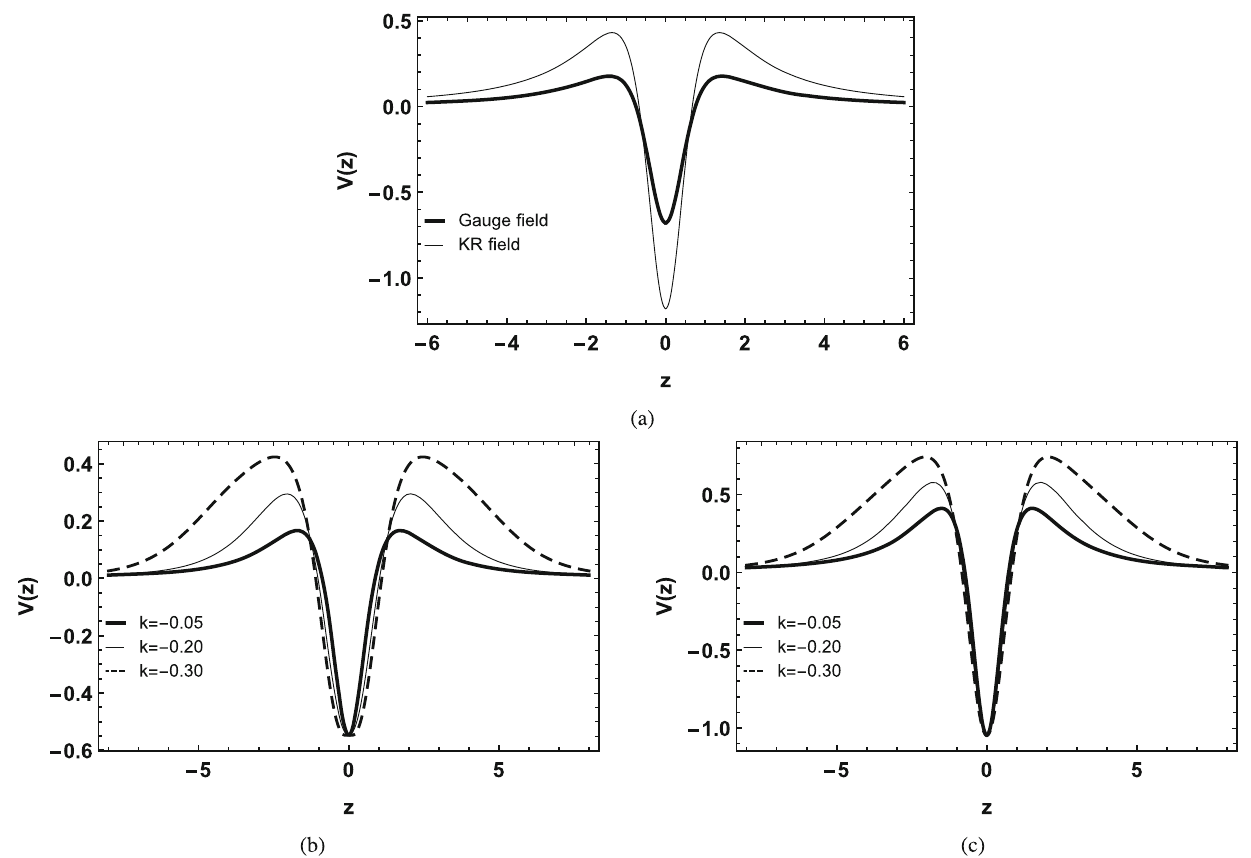
Fig. 2 Effective potential behavior for G 1 (φ) with p = λ = 1. a n = 1. Being b = 4 and n = 2. b Gauge field. c KR field